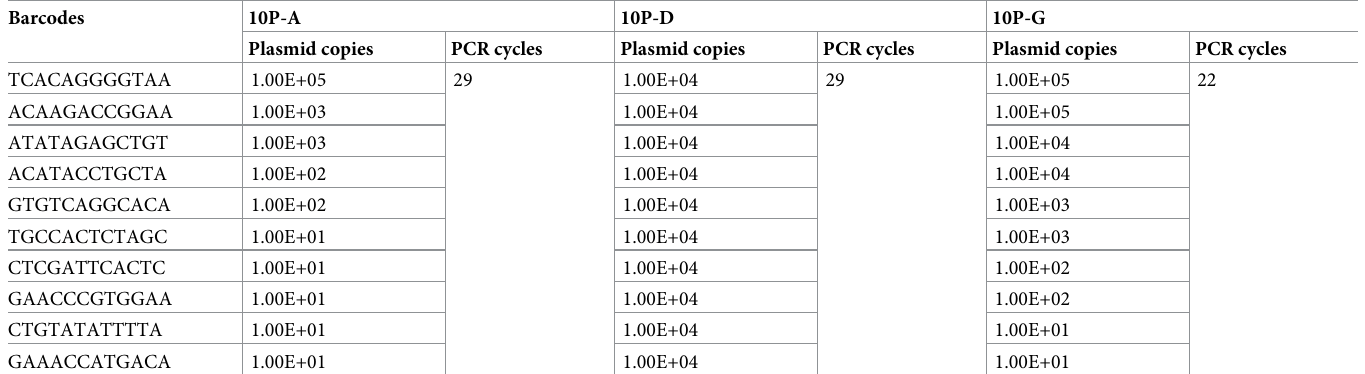
Table 3. 10-plasmid controls